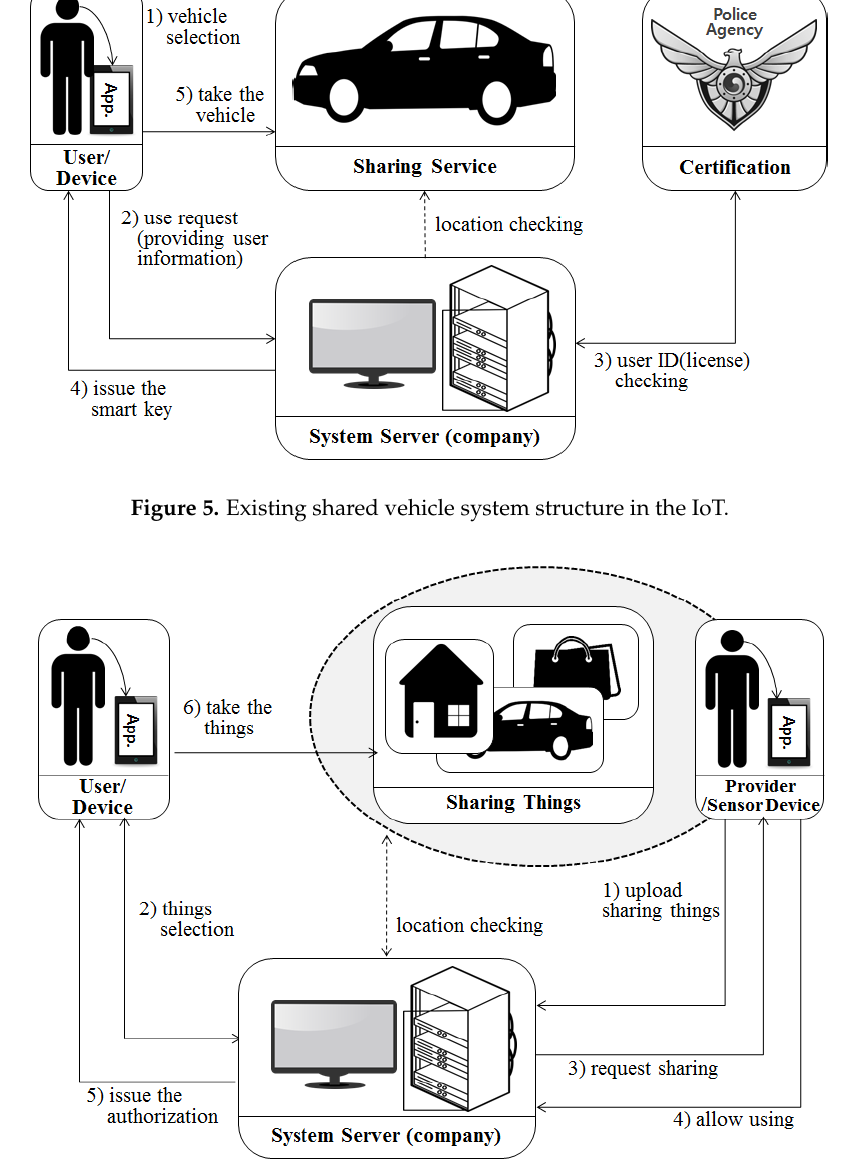
Figure 6. Structure of an existing house sharing system.